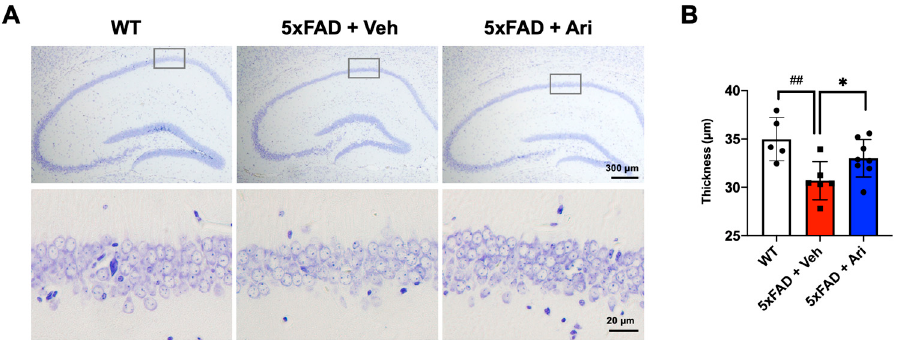
Figure 5. Aripiprazole prevented neuron loss in the hippocampus of 5xFAD mice. ( A ) Representative cresyl violet staining images of the hippocampal region of the indicated groups and ( B ) thickness quantification in the CA1 region. Statistical significance using one-way ANOVA defined as ## p < 0.01 WT ( n = 5) vs. 5xFAD + Veh ( n = 6); * p < 0.05 5xFAD + Veh vs. 5xFAD + Ari ( n = 8) group. Error bars indicate SD.